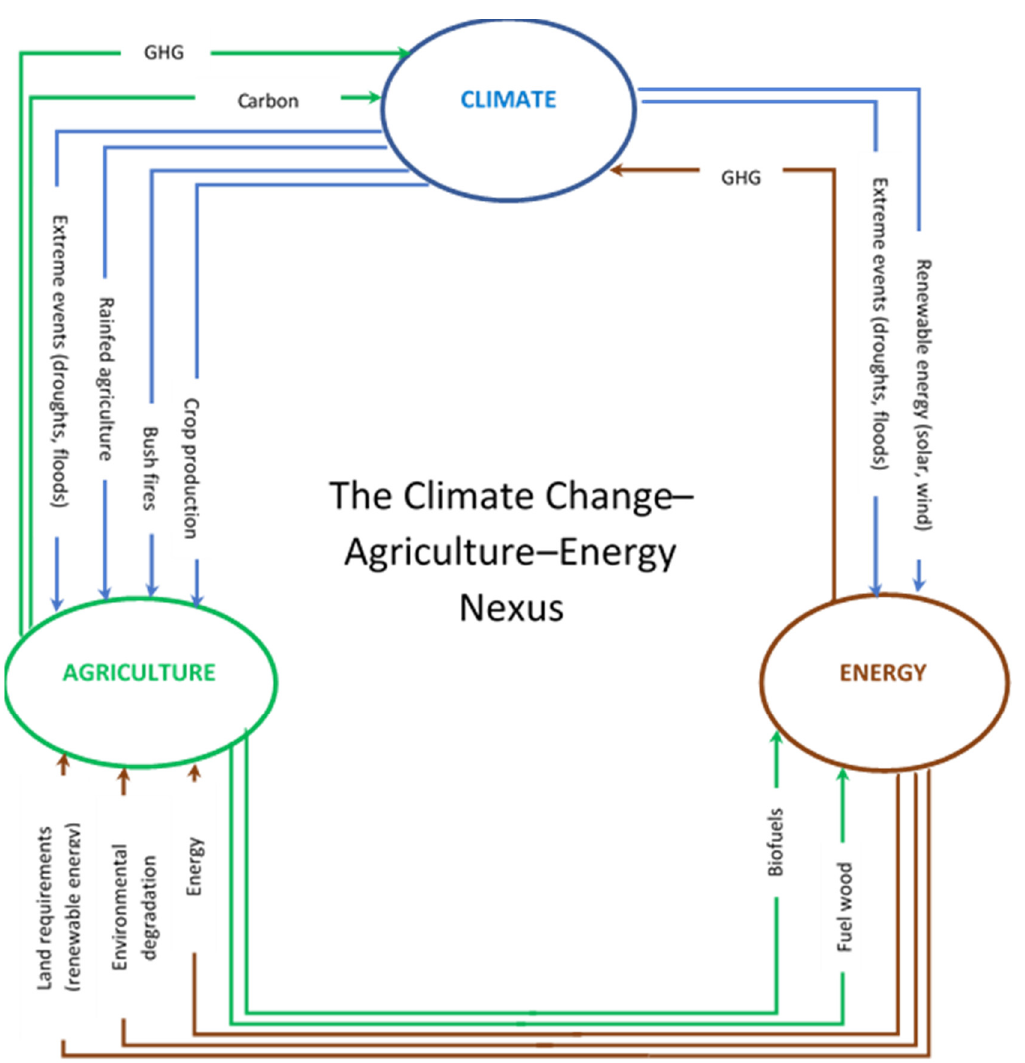
Figure 1. The climate change ‒ agriculture ‒ energy nexus. Adapted from Sridharan et al. [3].